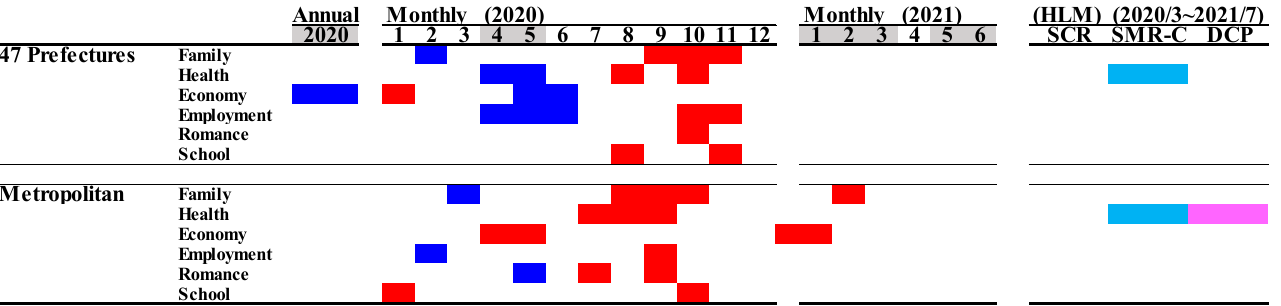
Figure 12. Comparison of annual and monthly SMR-S of males and females caused by suicidal motives during the pandemic period compared to average SMR-S of the same month during the pre-pandemic period, and impact of COVID-19 pandemic on SMR-S in Japan. Blue and red columns indicate significant decreasing and increasing suicide mortality using a linear mixed-effects model with Tukey’s multiple comparison ( p < 0.05). Light blue and red columns indicate significant decreasing and increasing factors against SMR-S using hierarchical linear model with robust standard error ( p < 0.05). SMR-S: standardised suicide mortality per 100,000 people. SCR: standardised infection with COVID-19 per 100,000 people. SMR-C: standardised mortality caused by COVID-19 per 100,000 people. DCP: during COVID-19 pandemic.